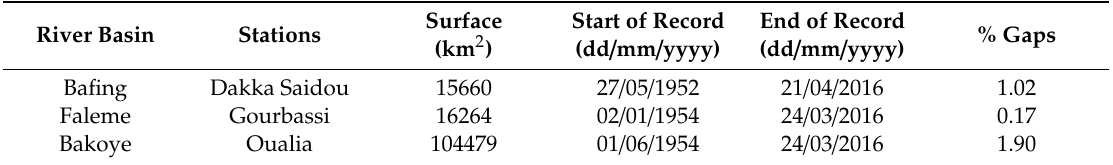
Table 1. Available discharge